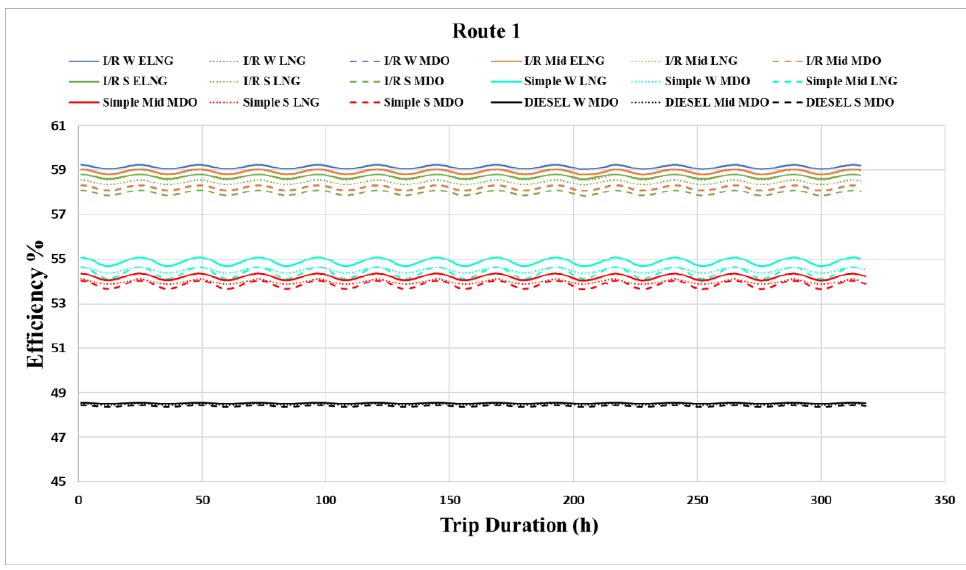
Figure 6. Performance of various propulsion systems of the large container ship travelling between Shanghai and Los Angeles. I/R: intercooler/reheater CCGT; S: simple CCGT; Diesel: two-stroke diesel engine; W: winter; Mid: midseason; S: summer season; ELNG: enhanced liquified natural gas; MDO: marine diesel fuel; LNG: liquified natural gas.